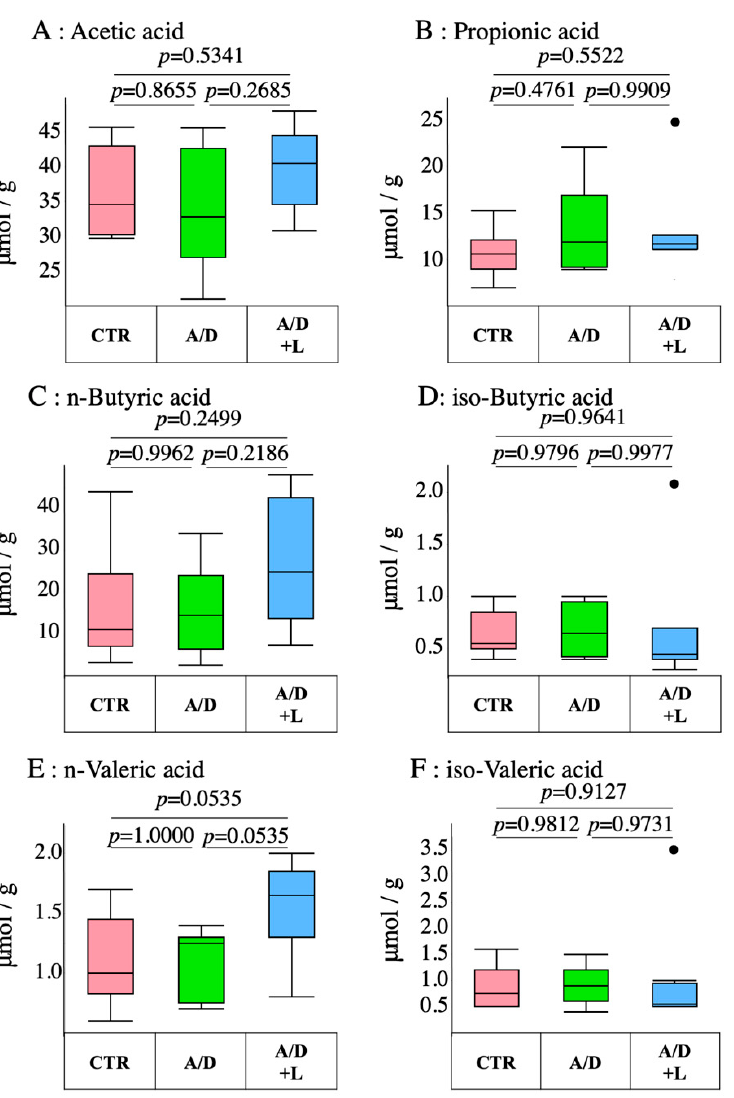
Figure 4. Analysis of short-chain fatty acid levels in the AOM/DSS model. The amounts of acetic acid ( A ), propionic acid ( B ), n -butyric acid ( C ), isobutyric acid ( D ), n -valeric acid ( E ), and isovaleric acid ( F ) in the cecal contents of the control (CTR), AOM/DSS (A/D), and AOM/DSS + lactulose (A/D+L) groups. Circles in the figure ( D , F ) are outliers, respectively. Data are shown in boxplots. ( n = 8).